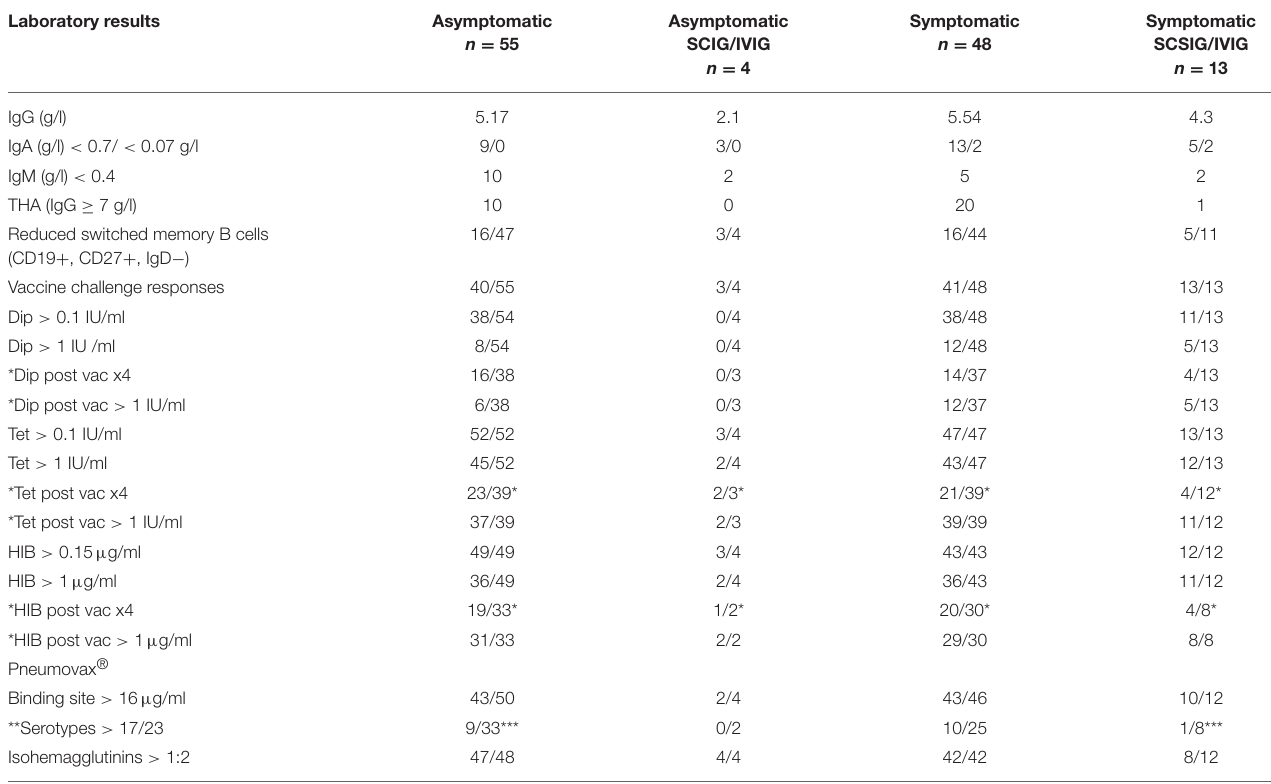
TABLE 2 | Laboratory results including vaccine